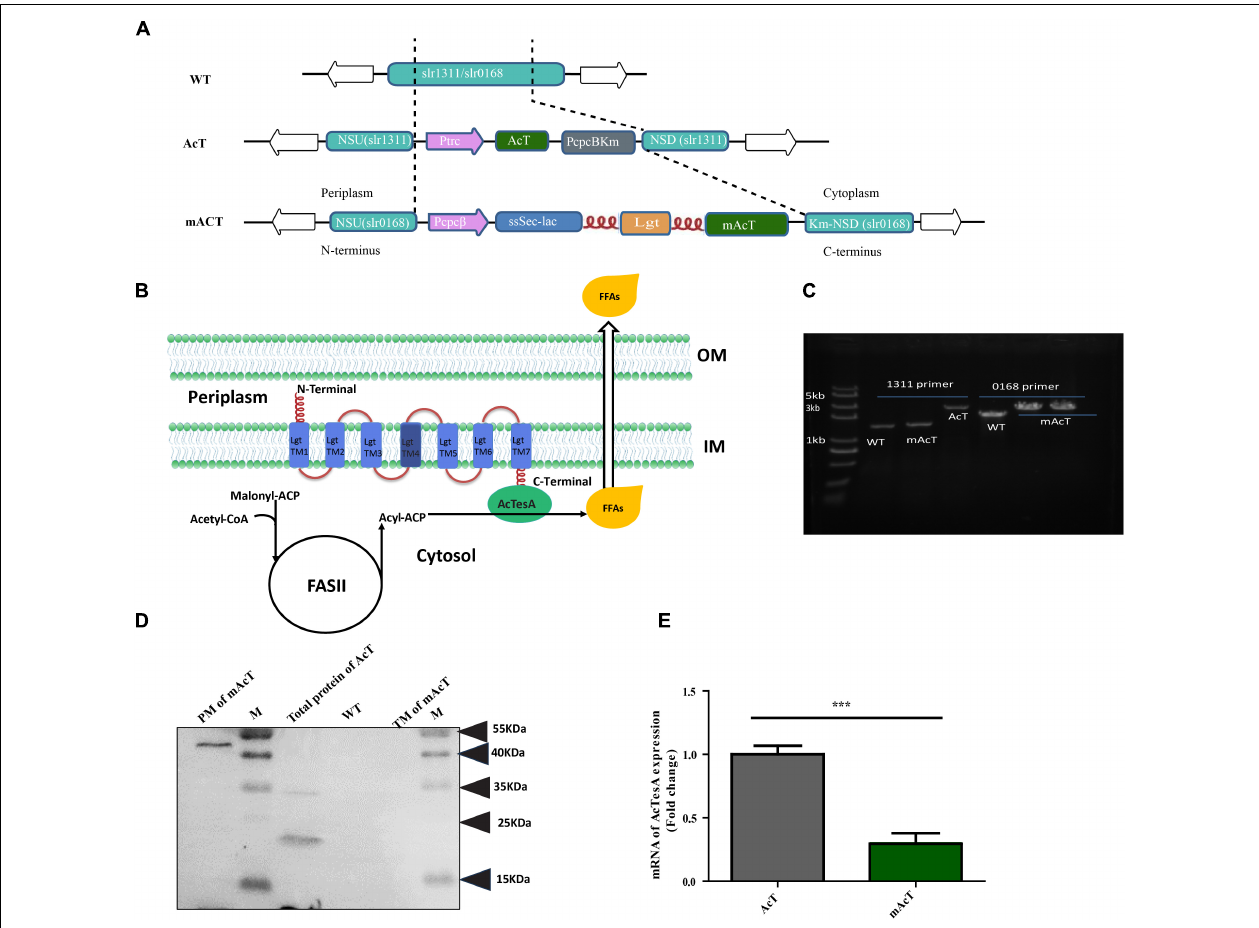
FIGURE 1 | Generation of fatty acid-producing mutant strains using synthetic protein scaffold on the membrane of Synechocystis sp. PCC6803. (A) Design of gene arrangement in WT, AcT and mAcT strain. The dashed line indicates the neutral sites for the insertion of target genes. In AcT, ‘AcTesA is the truncated thioesterase from Acinetobacter baylyi ; Ptrc is the promoter; NSU and NSD are the upstream and downstream flanking regions of the slr1311 , respectively; Km is the kanamycin resistance cassette. In mAcT, PcpcB is the promoter; NSU and NSD are the upstream and downstream flanking regions of the deleted gene, slr0168 , respectively. In the –ssSec-lac-lgt-‘AcTesA- cassette, ssSec is the signaling sequence; lac is β -lactamase; lgt is phosphatidylglycerol: prolipoprotein diacylglycerol transferase, an inner membrane protein; flexible linker FL3 (red color and coil-shaped) is introduced between proteins to fuse β -lactamase to the N-terminus and ‘AcTesA to the C-terminus of Lgt. (B) Hypothetical presentation of the mechanism of membrane-localized ‘AcTesA in generating and facilitating the excretion of FFAs outside the cell. (C) PCR confirmation of the insertion in the AcT and mAcT mutant strains. Lane M is a marker. Lanes 1, 2, and 3 are bands of DNA amplified using primers NSUF (1311) and NSDR (1311) to confirm the –AcT-PcpcKm- insertion. In lanes 4–6, the primers NSUF (0168) and NSDR (0168) were used to amplify the –PcpcBssSecLacLgtAcTesAKm-cassette insertion to confirm the insertion with around 3.7 kb in size. WT is the band without target insertion around 1.9 and 1 kb with the primer pair NSUF/NSDR (0168) and NSUF/NSDR (1311), respectively. (D) Western blot analysis of fractionated protein from mAcT and total crude AcT. Here, M is the marker; PM, plasma membrane; TM, thylakoid membrane; WT, total crude protein from WT Synechocystis . MW of ‘AcTesA is approximately 20 kDa and Lgt-‘AcTesA fusion is approximately 50 kDa. (E) qRT-PCR analysis of expression of ‘AcTesA. Data shown here are the mean ± SE from biological triplicates with 4 technical replicates and “ ∗ ” represents statistical significance as indicated by Student’s t -test with a maximum p -value of <